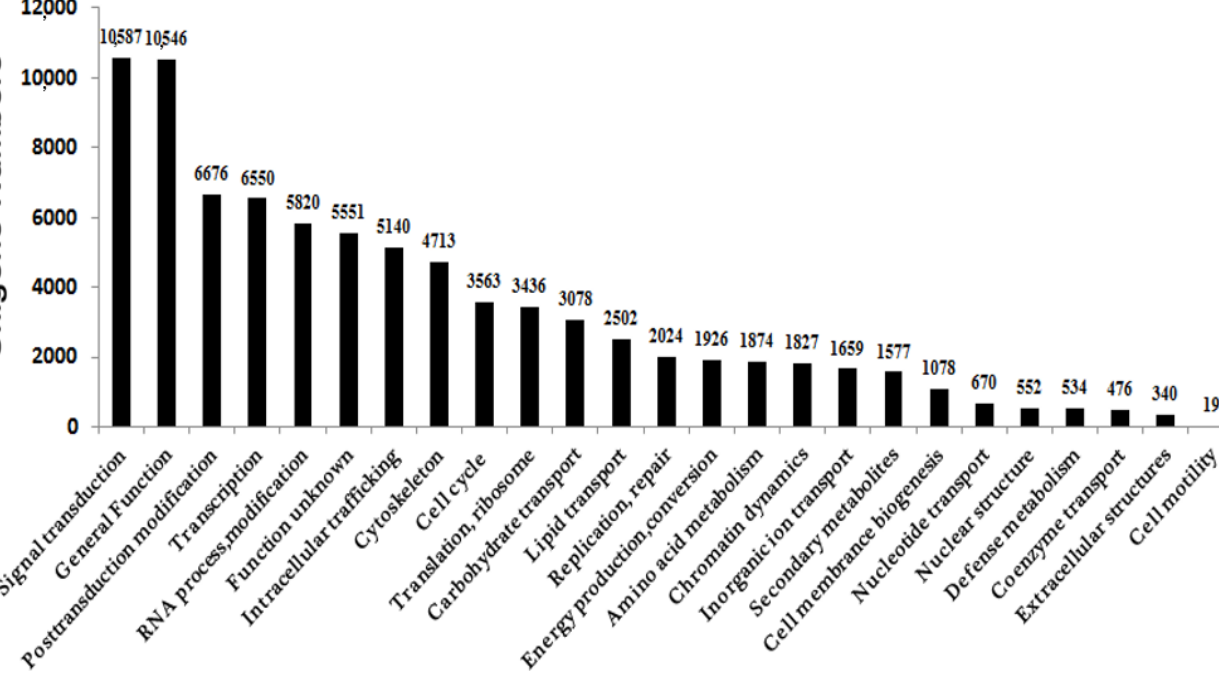
Figure 3. COG annotations of Brassica juncea unigenes. In total, 82,718 unigenes were classified into 25 COG categories.